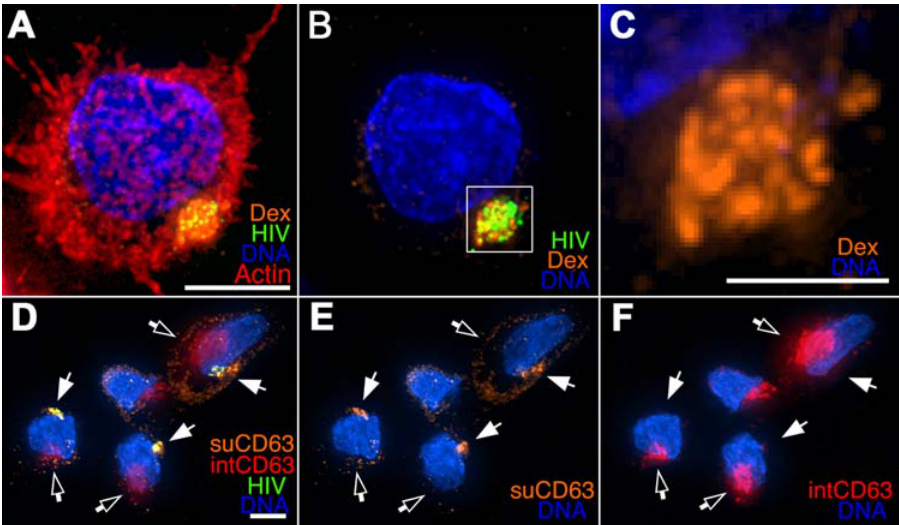
Figure 7. Internalized HIV is accessed by a surface-applied fluid phase marker. (A–C) Mature MDDCs were pulsed with HIV as in Figure 6 and incubated with fluorescent dextran (orange) at 4 u C. Cells were plated onto coverslips, fixed, and stained for Actin (Red) and DNA (Blue). (A) 3-D view of the entire cell volume. (B) Same as (A), without Actin. (C) Magnified view of compartmentalized dextran signal (boxed region). (D–F) Surface accessibility distinguishes the HIV compartment from endosomal structures. DCs were prepared as above and incubated with anti-CD63 at 4 u C, washed, fixed, and immunostained with labeled anti-mouse antibody (orange). Internal CD63 (red) was then detected using the same anti-CD63 mAb and pre-labeled with a different fluorophore after detergent treatment to remove cell membranes. DNA is labeled in blue; images are 3-D views of whole-cell volumes. Solid arrows denote surface-applied anti-CD63 stained, compartmentalized HIV; open arrows denote lysosomal CD63-positive compartments that are not stained by the surface-applied antibody. Bars (A, B, D–F) 5 m ; (C) 2 m .